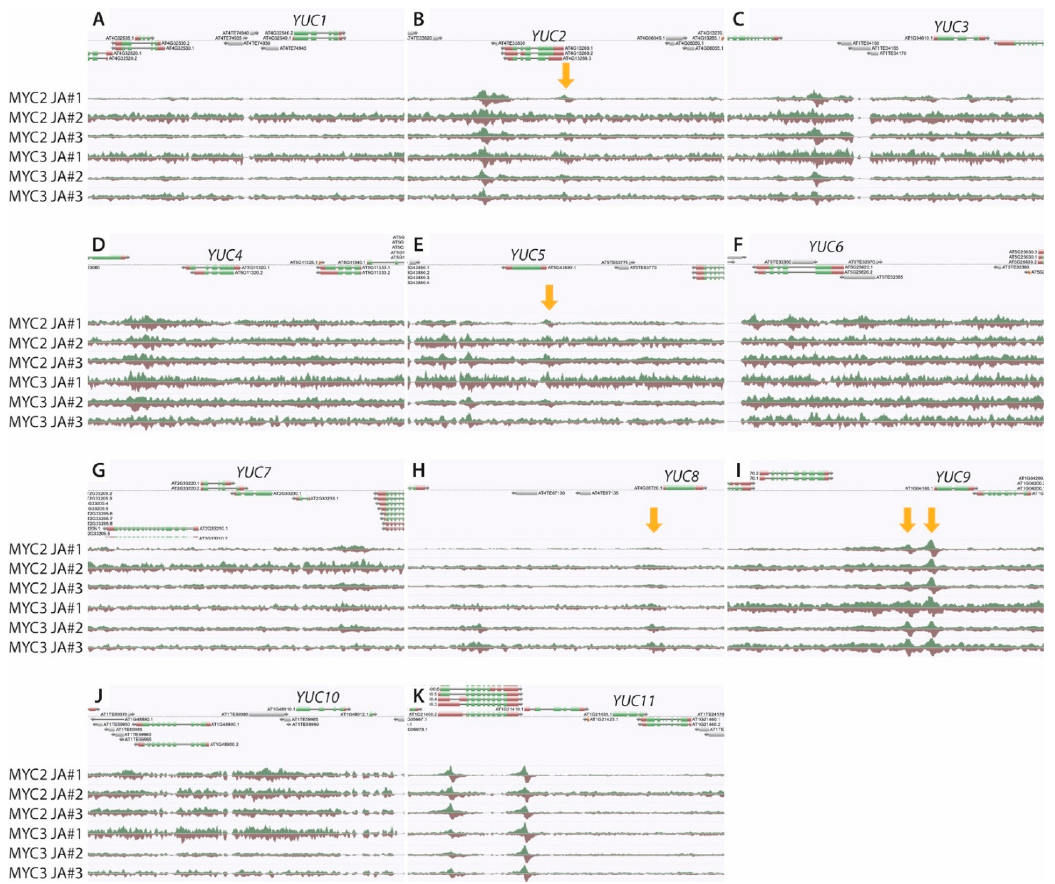
Figure A1. Genome browser screenshots showing the binding of MYC2 and MYC3 to the promoter regions of the eleven YUCCA genes. The figure shows the genomic regions around ( A ) YUC1 , At4g32540; ( B ) YUC2 , At4g13260; ( C ) YUC3 , At1g04610; ( D ) YUC4 , At5g11320; ( E ) YUC5 , At5g43890; ( F ) YUC6 , At5g25620; ( G ) YUC7 , At2g33230; ( H ) YUC8 , At4g28720; ( I ) YUC9 , At1g04180; ( J ) YUC10 , At1g48910; and ( K ) YUC11 , At1g48910. The corresponding YUCCA genes are marked in each panel. Possible binding sites, represented by an enrichment of sequence reads obtained from either MYC2 or MYC3 ChIP-seq assays, in the YUC promoters are highlighted by arrows. The data have been extracted from Zander et al. [40]. Array results are available under: http://neomorph.salk.edu/MYC2, last accessed: 8 September 2021.